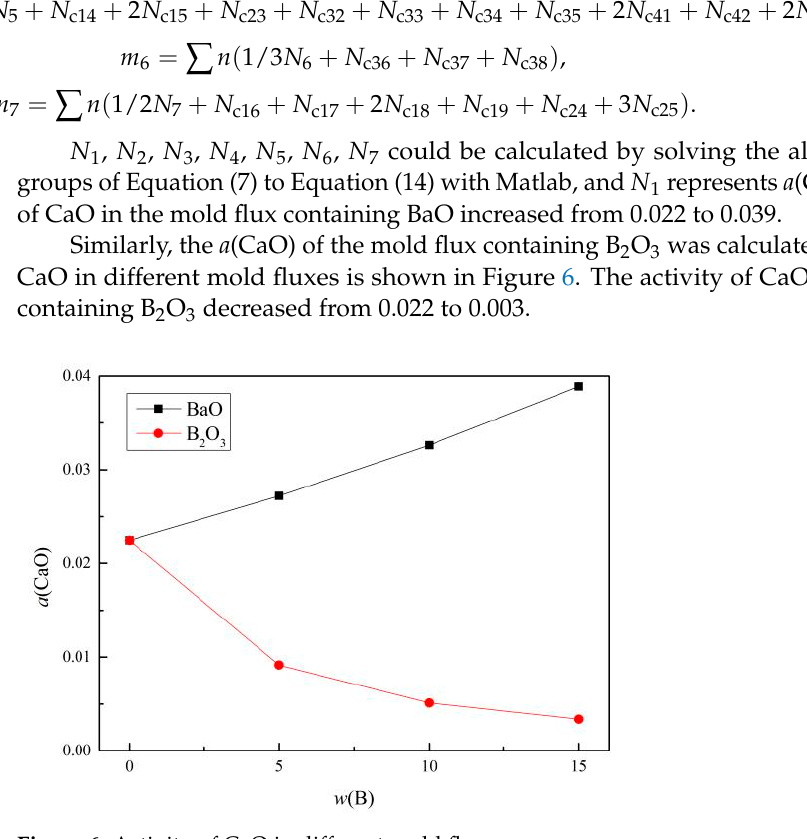
Figure 6. Activity of CaO in different mold fluxes. With the increase in BaO in the mold flux, the activity of CaO increased, which promoted the combination of CaO and TiO 2 to form CaTiO 3 , thus increasing the mass transfer capacity of TiO 2 , as shown in Equation (15). CaO + TiO 2 = CaTiO 3 . The increase in B 2 O 3 in the mold flux reduces the activity of basic oxides and inhibits the binding ability of TiO 2 and